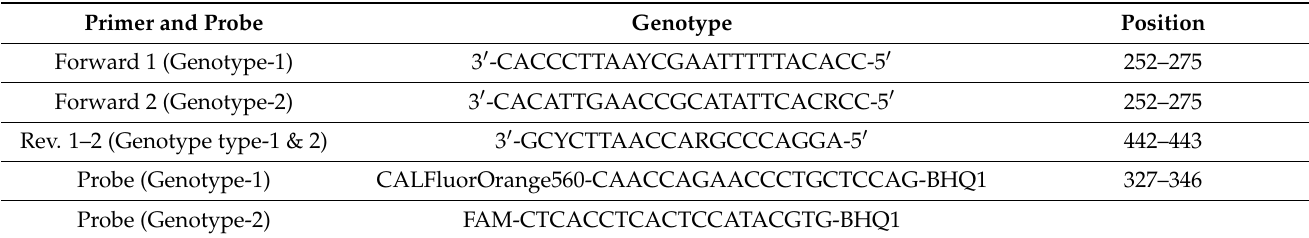
Table 1. AAVV-6 fusion real-time RT-PCR primers and